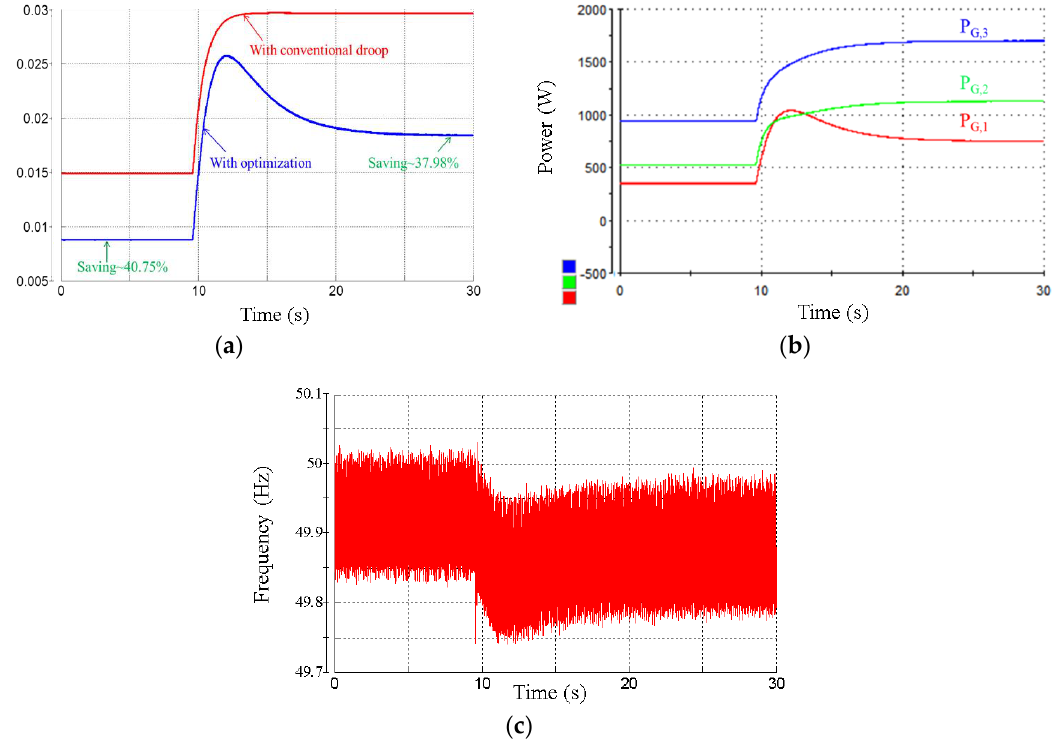
Figure 14. Experimental results of transient response of load changing with proposed algorithm. ( a ) operation cost; ( b ) real power; and ( c ) frequency given.